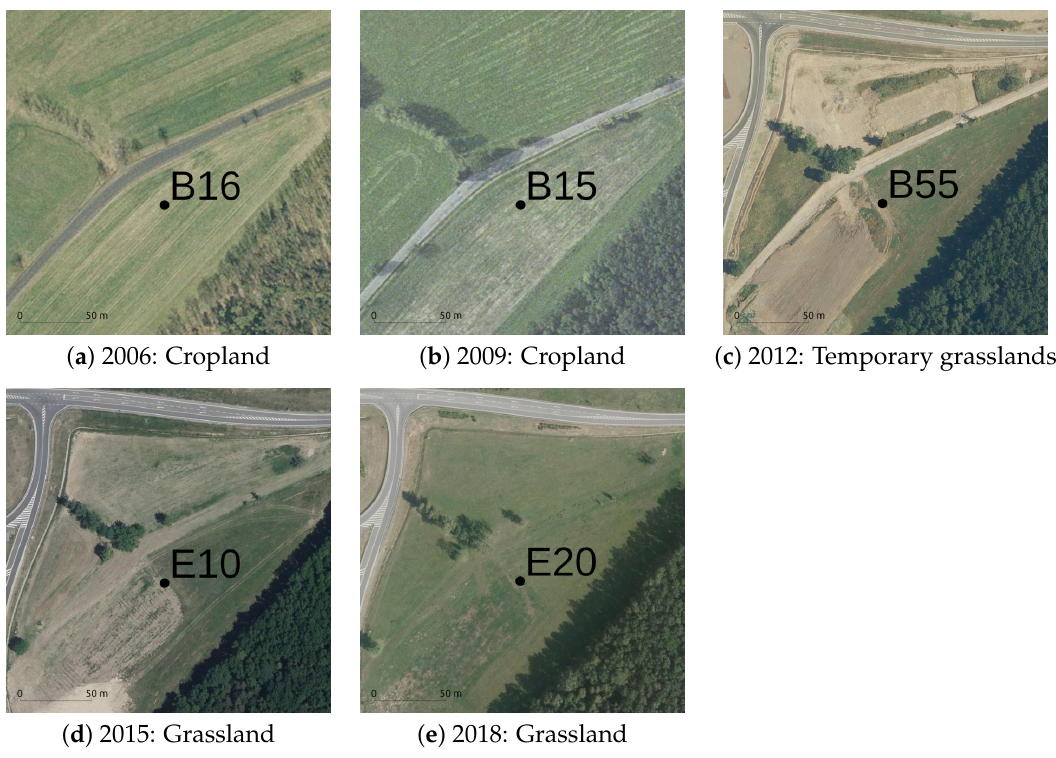
Figure 9. Example of changing land cover over time for POINT_ID = 46642928 as recorded in the LUCAS dataset (background orthophotos: Czech State Administration of Land Surveying and Cadastre—public WMS view